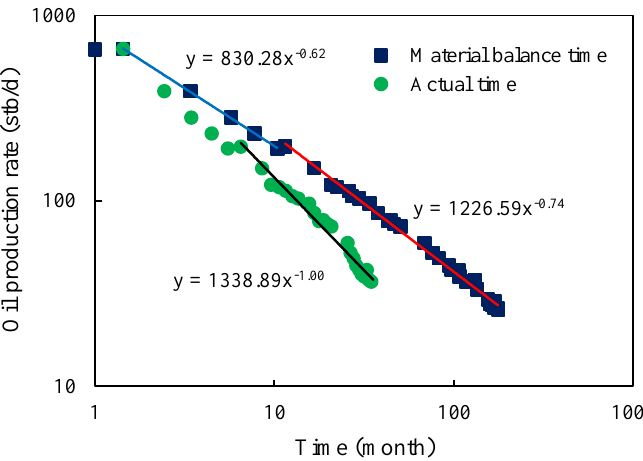
Figure 12. Plot of production rate data for Well #6.